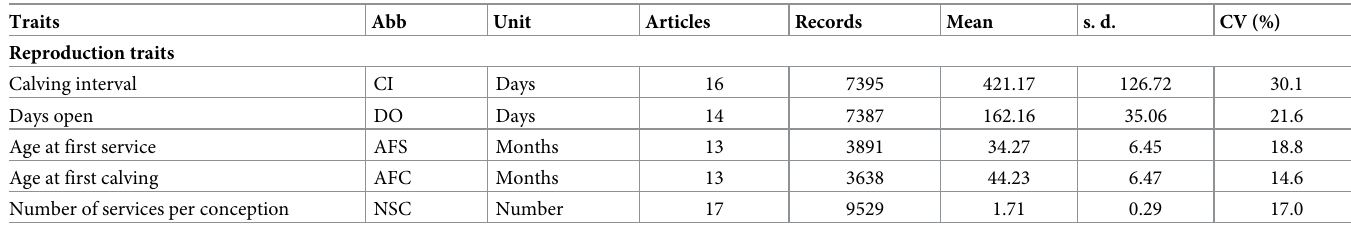
Table 1. Mean phenotypic traits of reproduction in Boran cattle